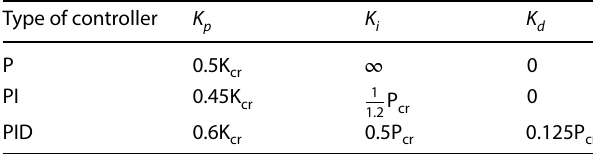
Table 1 PID controller parameters for Ziegler-Nichols method Type of controller